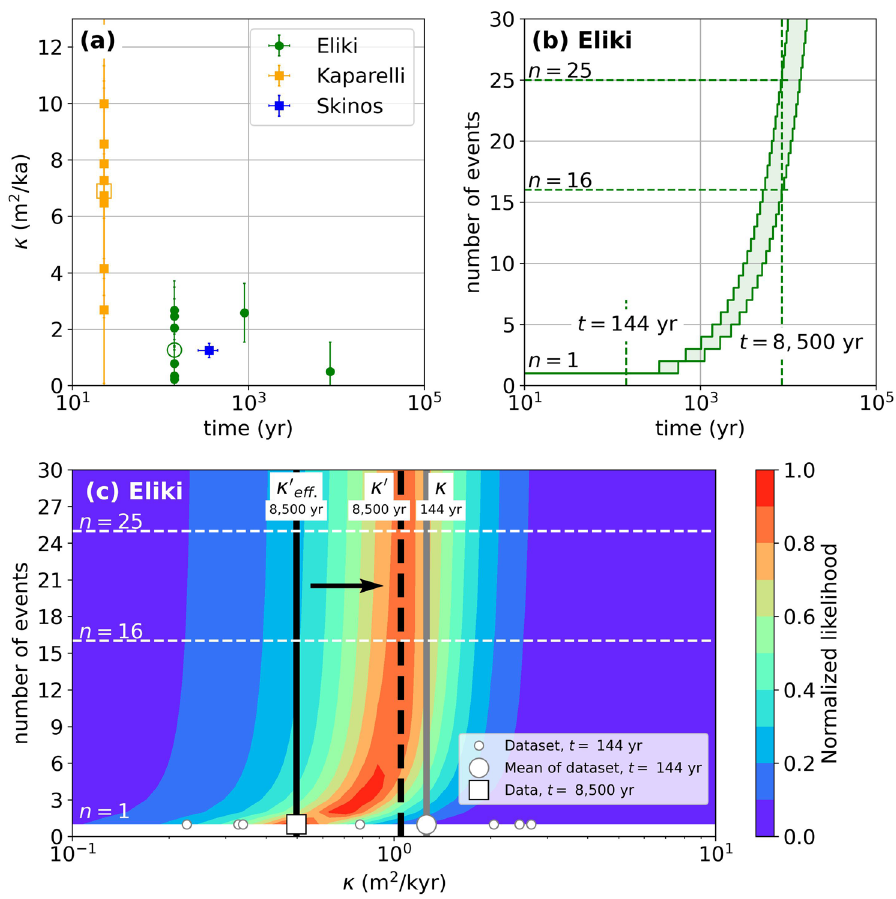
Figure 5. Influence of the number of events on the diffusivity coefficient κ as inferred from measurements along active faults in Greece. ( a ) Time variation of κ along the Eliki, Kaparelli, and Skinos faults, as proposed by Kokkalas and Koukouvelas 9 . ( b ) Relationship between the number of events and the degradation time along the Eliki fault 9 . ( c ) Likelihood of scarp profiles along the Eliki fault, assuming a single-event scarp that degraded 0.5 m 2 /kyr as the “true model”. The vertical black line and the white square give during 8500 years with κ ′ eff . ∼ the effective diffusivity determined in a trench, assuming a single event scenario 9 . The thick vertical dashed line is associated with κ ′ = 1.05 m 2 /kyr as re-assessed from the calculated likelihood distribution and taking into account the 16–25 events that potentially ruptured this fault over the last 8500 years. Small circles give the diffusivity from field measurements on the fault scarp formed after the 1861 Eliki earthquake. These individual values yield a mean diffusivity of 1.26 m 2 /kyr for a duration of t = 144 years (large circle and vertical gray line). Figure generated using the Python’s matplotlib